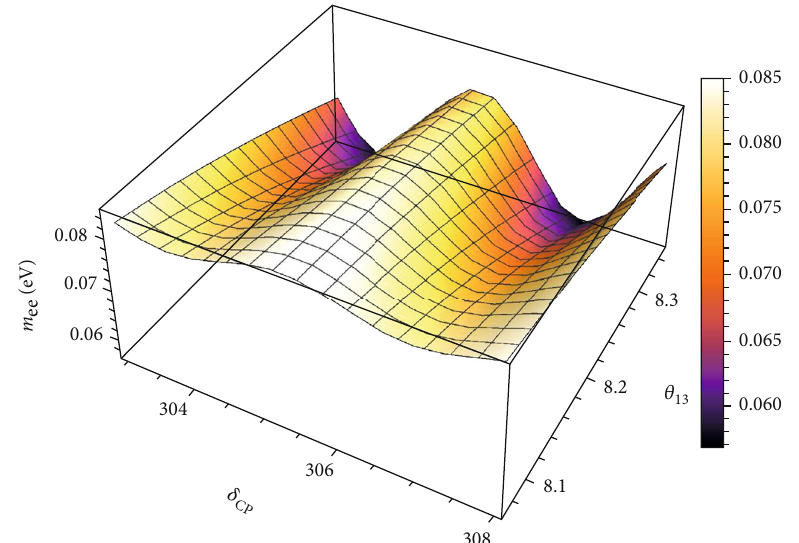
Þ for m , δ , θ [eV], 0 νββ decay for favoured values of m CP 13 ee ee